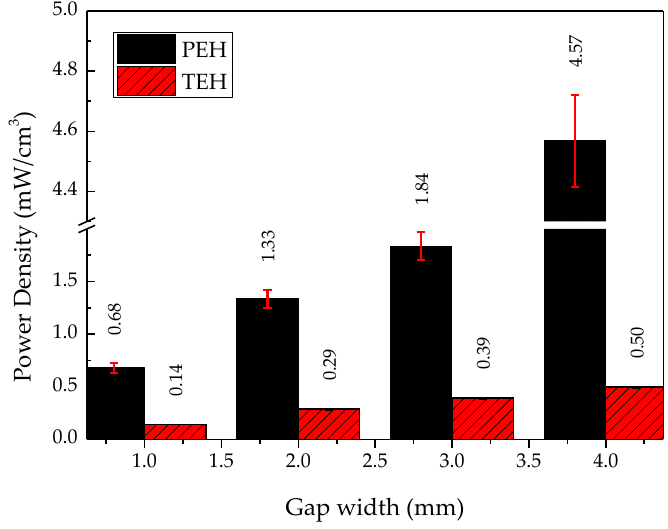
Figure 12. Power densities of PEH and TEH. Table 3. Power consumption of common small electronic devices.